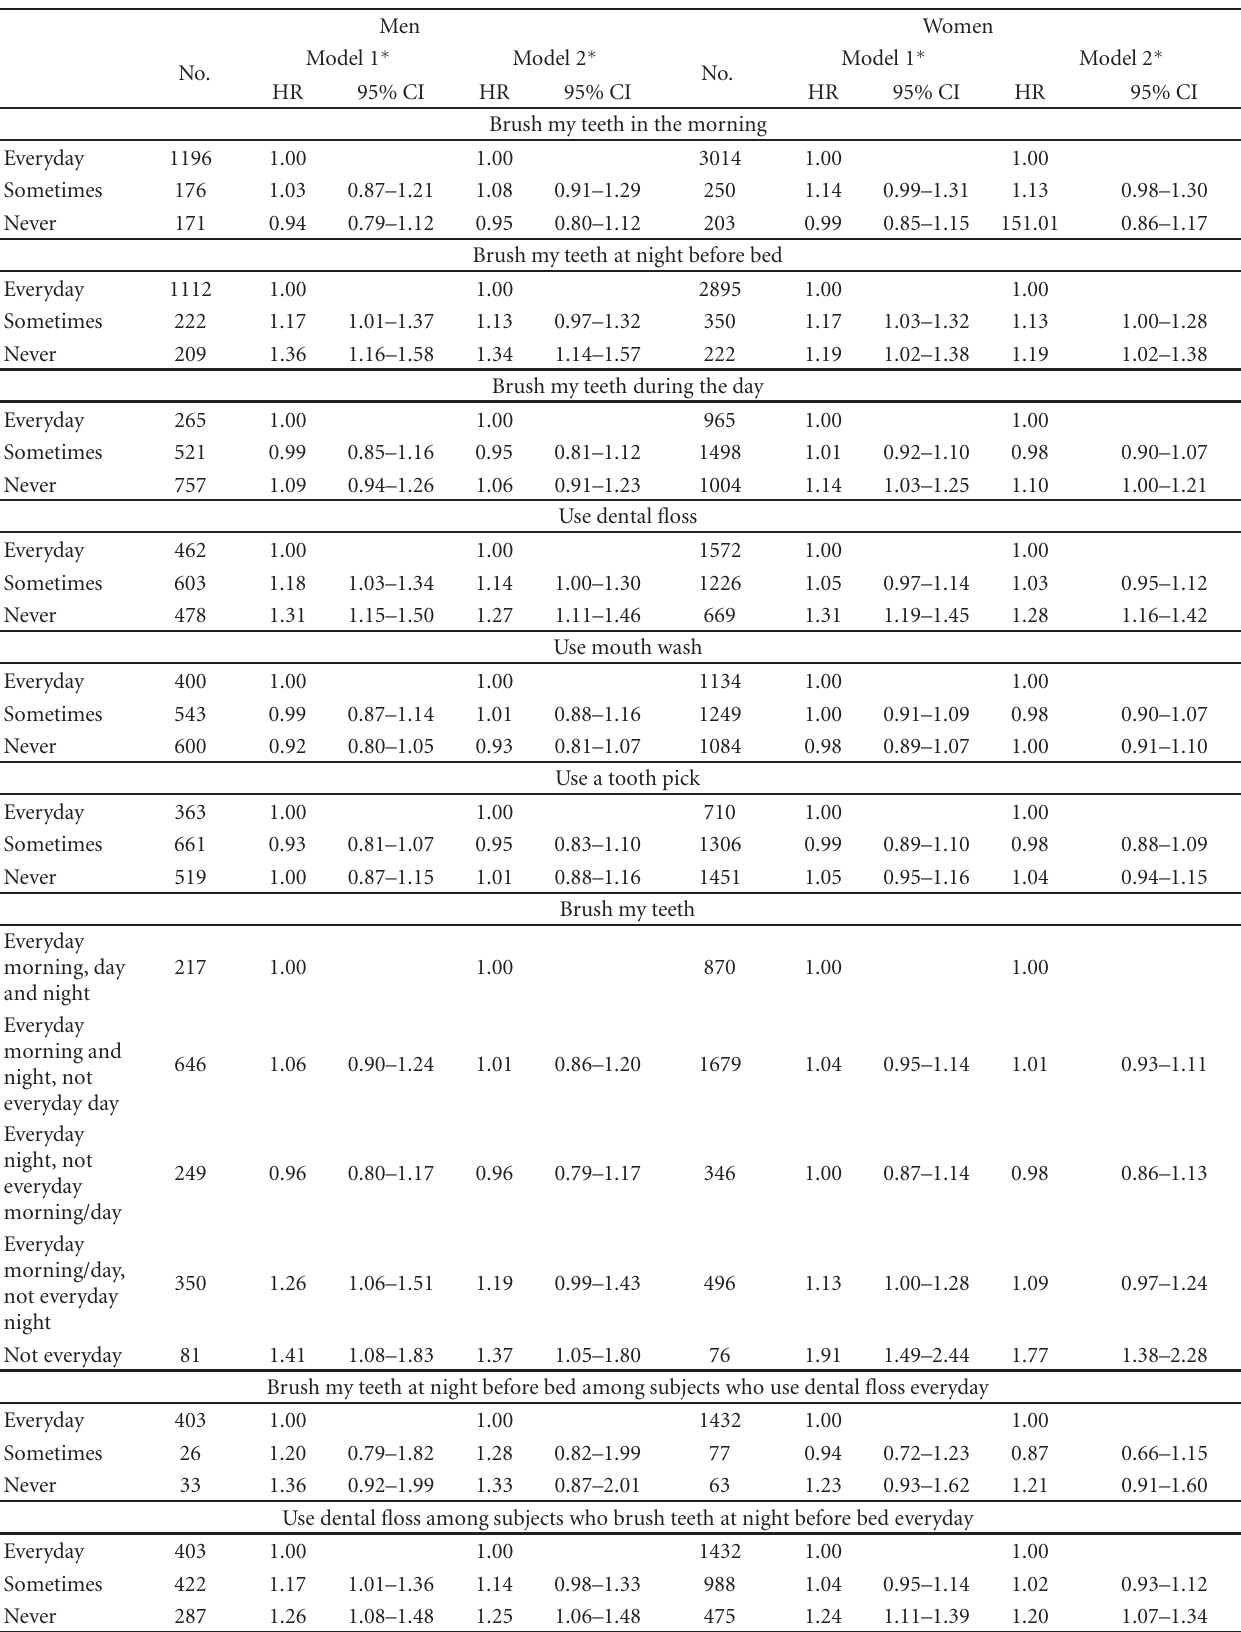
Table 3: Hazard ratios for mortality by dental health behaviors among subjects with teeth, Leisure World Cohort Study,